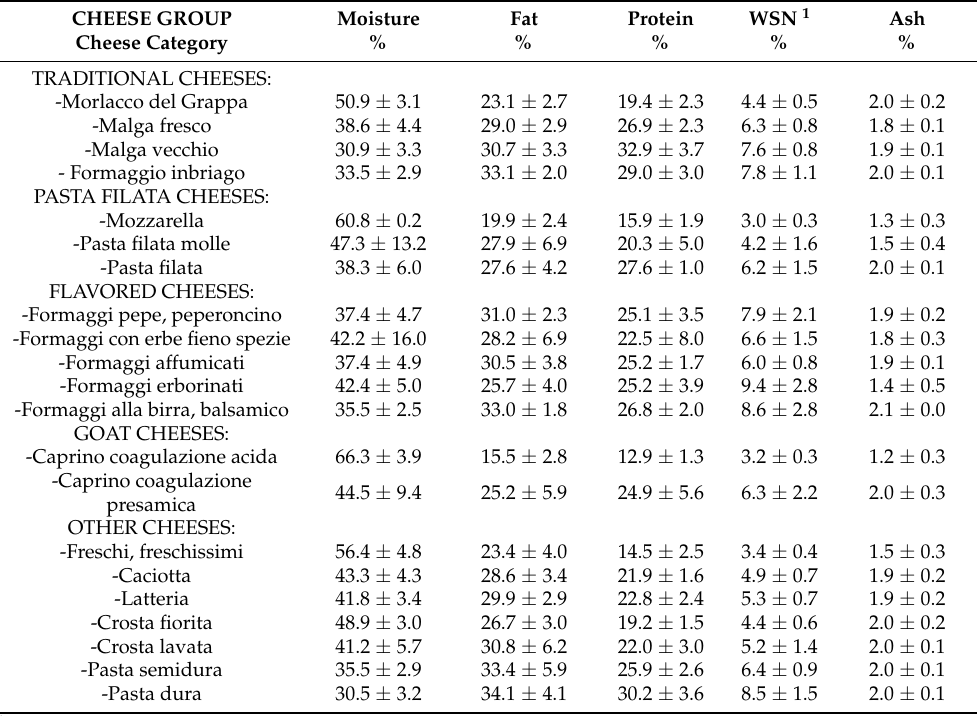
Table 6. Chemical compositions of the non-PDO cheeses (averages and standard deviations by cheese category expressed as % by